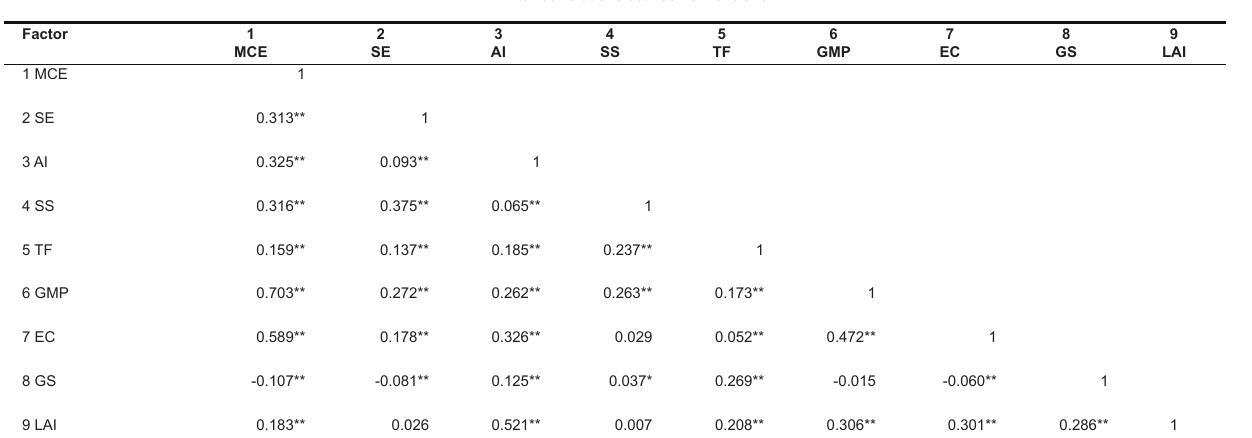
TABLE 4 EFA: Inter-correlations between dimensions